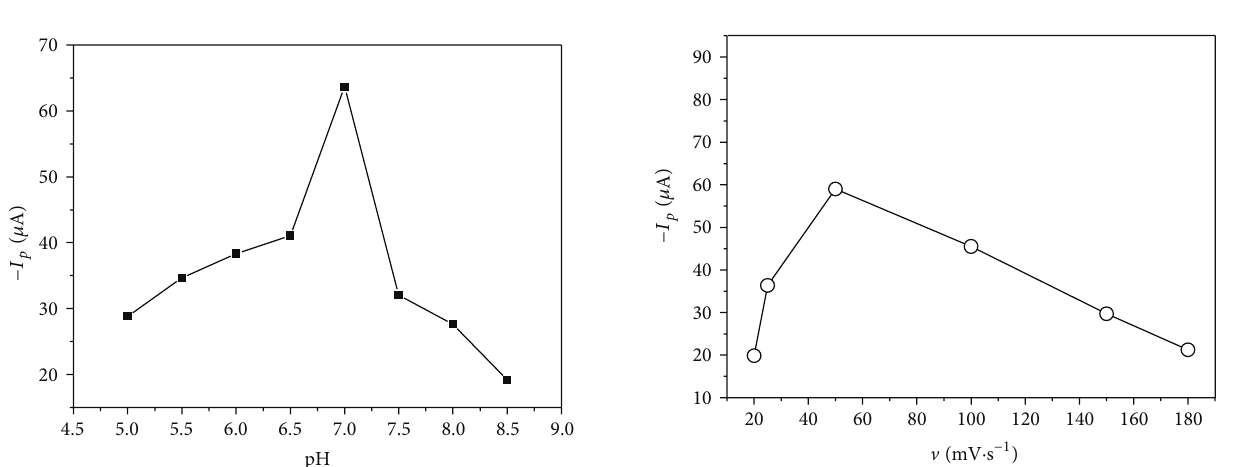
Figure 6: Electrocatalysis impact of poly-L-histidine modified elec- trode with different scanning speed.